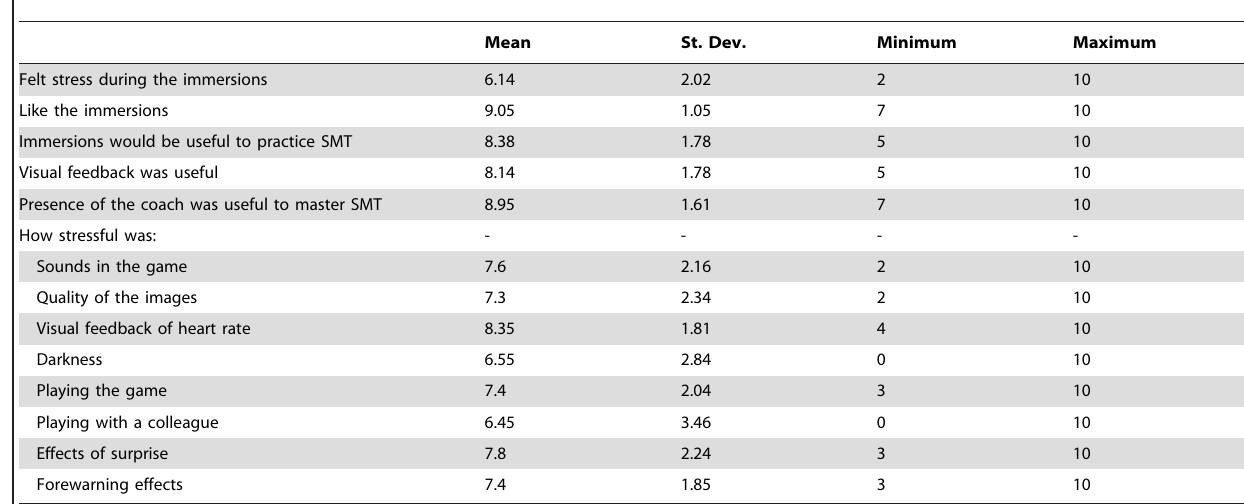
Table 6. Descriptive statistics from the survey assessing participant’s impression of the ImPACT program on scales ranging from 0 to